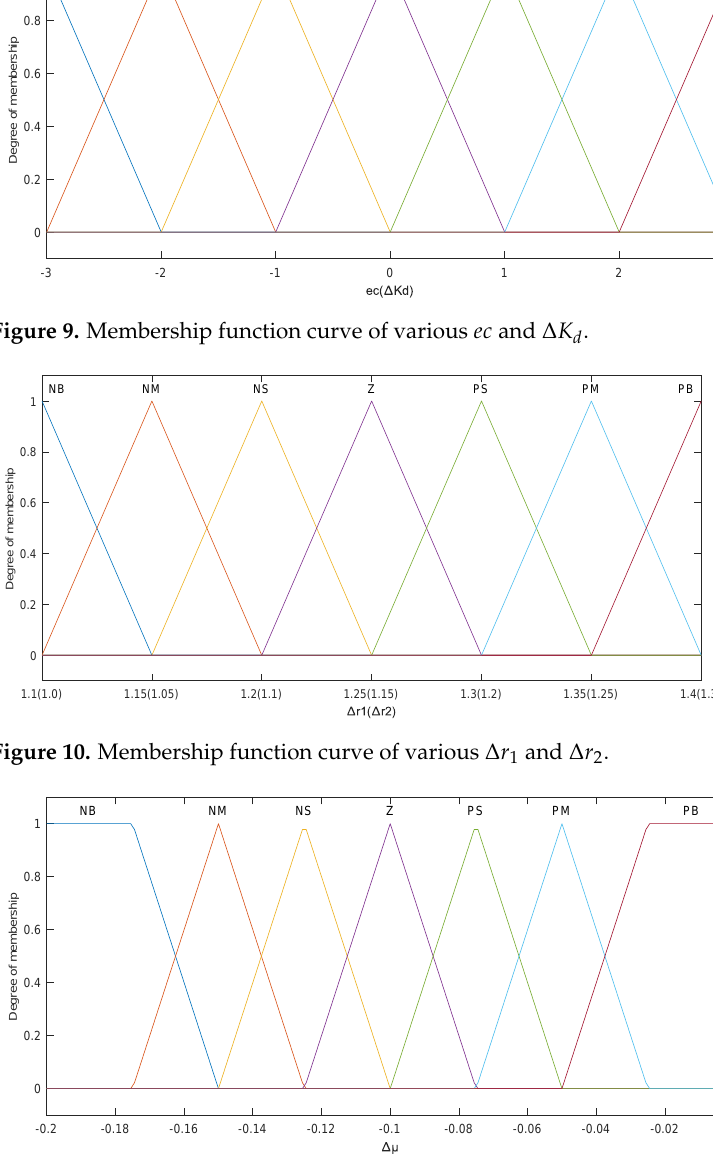
Figure 11. Membership function curve of various ∆ µ